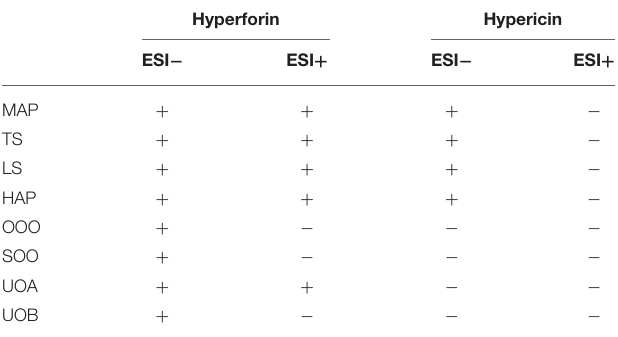
TABLE 4 | Summary of key chemical data. Hyperforin